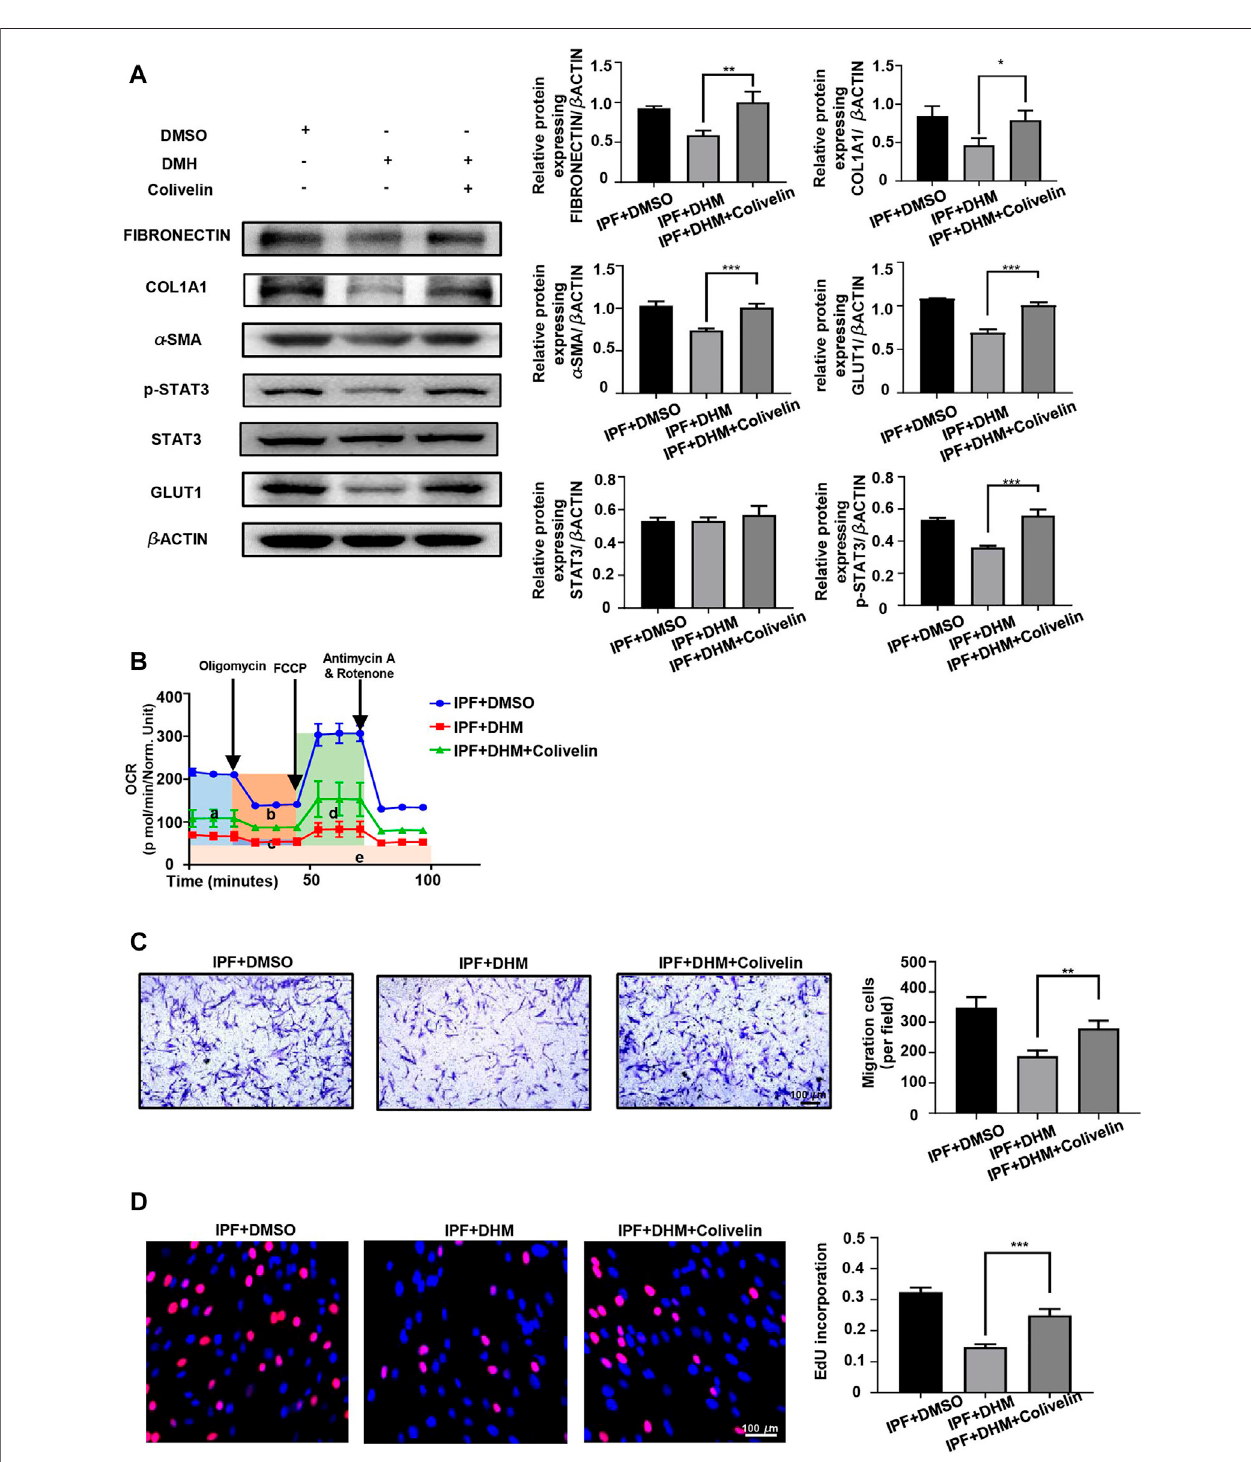
FIGURE7| ColivelinreversedtheeffectofDHMonPHLFs. (A) Westernblottinganalysisofthelevelsof fi bronectin,COL1A1, α -SMA,andSTAT3/p-STAT3/GLUT1 in colivelin-treated PHLFs ( n = 5). (B) Cell Mito Stress test results of colivelin-treated PLHMs (a: basal respiration, b: ATP production, c: proton leak, d: maximal respiration, e: nonmitochondrial respiration) ( n = 3). (C) Results for the Transwell assay in colivelin-treated PLHMs ( n = 5). (D) Results for EdU staining in colivelin-treated PLHMs( n =5).Thedataarerepresentedasthemean±SDofthreeindependentexperiments.Two-sidedStudent ’ st-testwasapplied.*, p < 0.05;**, p < 0.01;***, p <